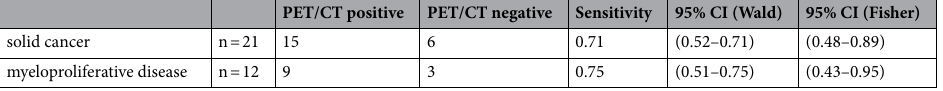
Table 3. Laboratory parameters in FUO/IUO. SD standard deviation, WBC range of white-blood-cell, CRP C-reactive protein levels.